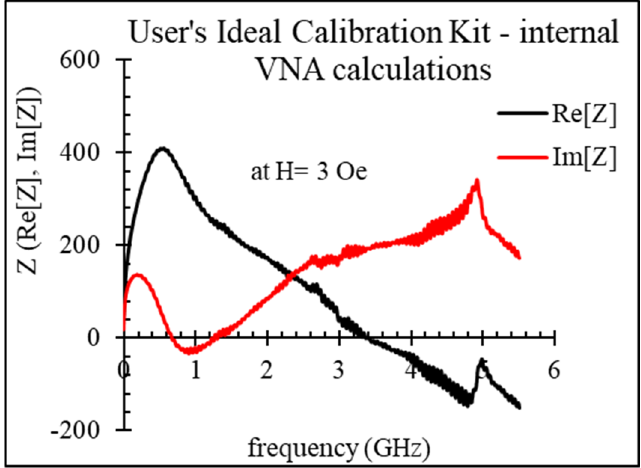
Figure 4. Dispersions of the impedance of amorphous Co 71 Fe 5 B 11 Si 10 Cr 3 microwire (sample No2, as- cast) obtained from using user’s ideal calibration kit created on VNA.